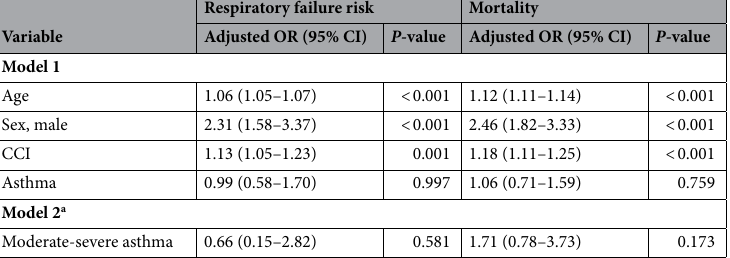
Table 3. Multivariate analyses of risk factors associated respiratory failure and mortality among total study population. OR, odds ratio; CI, confidence interval; CCI, Charlson comorbidity score. a Adjusted for age, sex (male), and CCI.